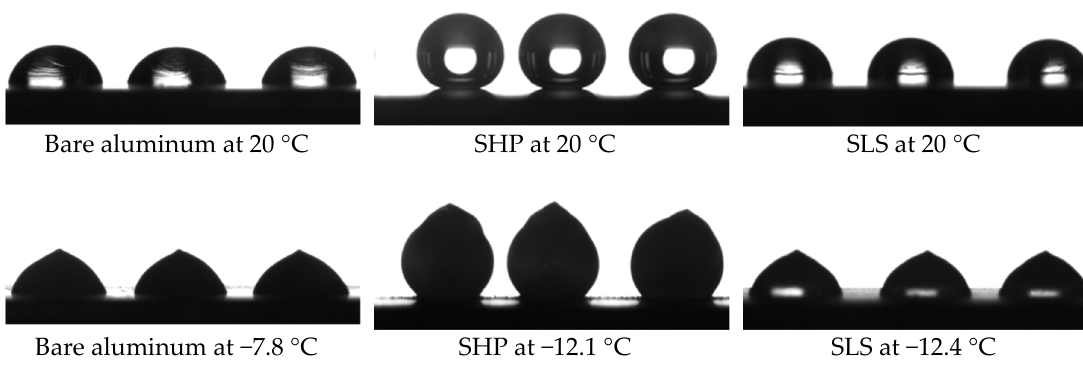
Figure 4. Icing nucleation temperature T n on different surfaces.